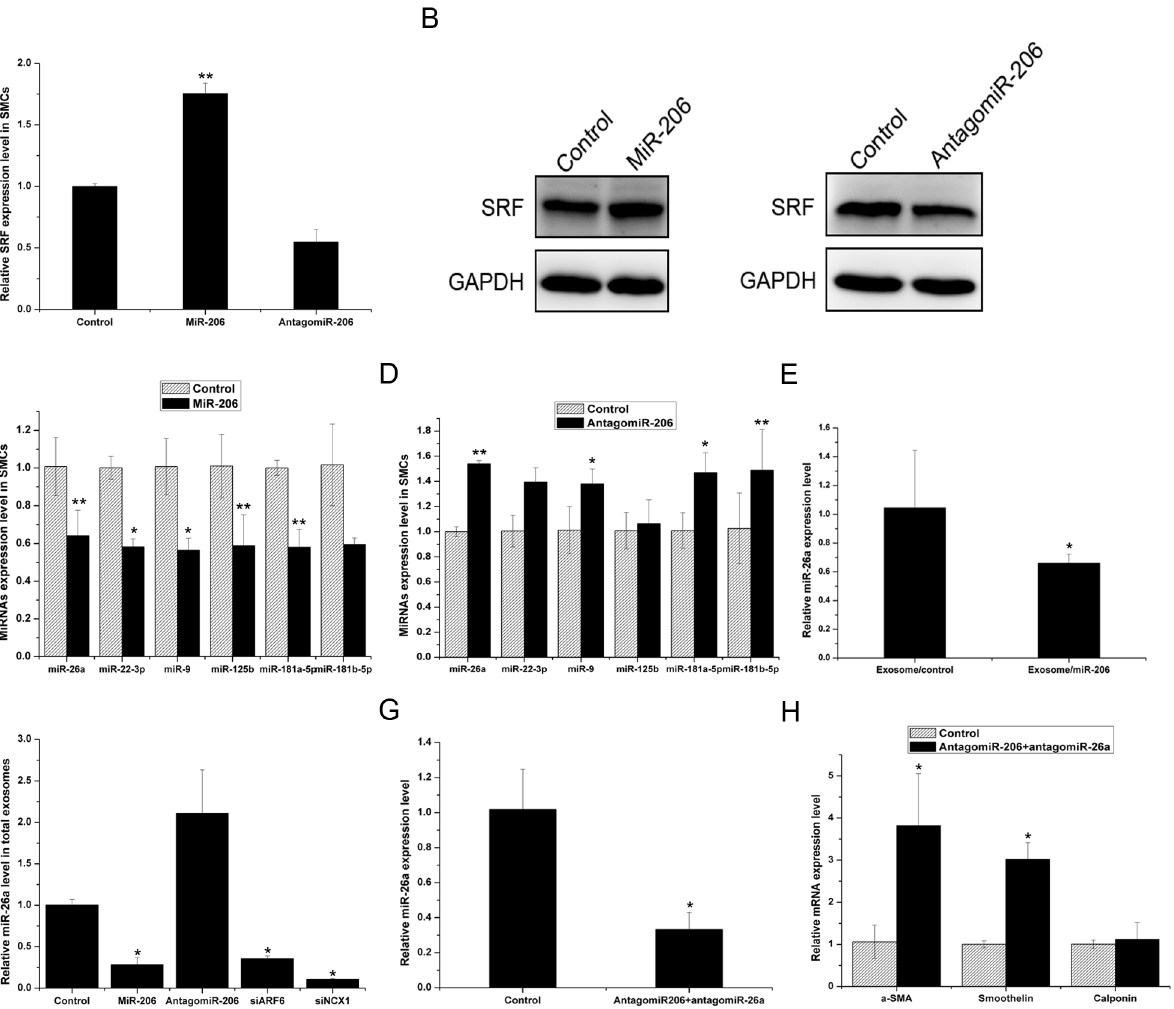
Fig 7. MiR-26a mediates the SMC phenotype regulation co-cultured with miR-206-overexpressing HUVECs. (A) Real-time PCR analysis of SRF expression in SMCs. (B) Western blot analysis of SRF protein level in SMCs. (C, D) Real-time PCR analysis of phenotype-related miRNA expression in SMCs co-cultured with miR-206-overexpressing HUVECs (C) and antagomiR-206-overexpressing HUVECs (D). (E) Real-time PCR analysis of miR-26a expression in SMCs treated with exosomes from miR-206-overexpressing HUVECs. (F) Real-time PCR analysis of miR-26a expression in the total exosomes from the same amounts of mock-, miR-206, antagomiR-206, siARF6 and siNCX1-transduced HUVECs. (G, H) Real-time PCR analysis of miR- 26a expression (G) and phenotype marker gene expression (H) in SMCs co-cultured with HUVECs co-transfected with antagomiR-26a and antagomiR-206 or mock. Three independent experiments were performed for each condition, and data are presented as the mean ± SEM. * p < 0.05 and ** p < 0.01 versus control